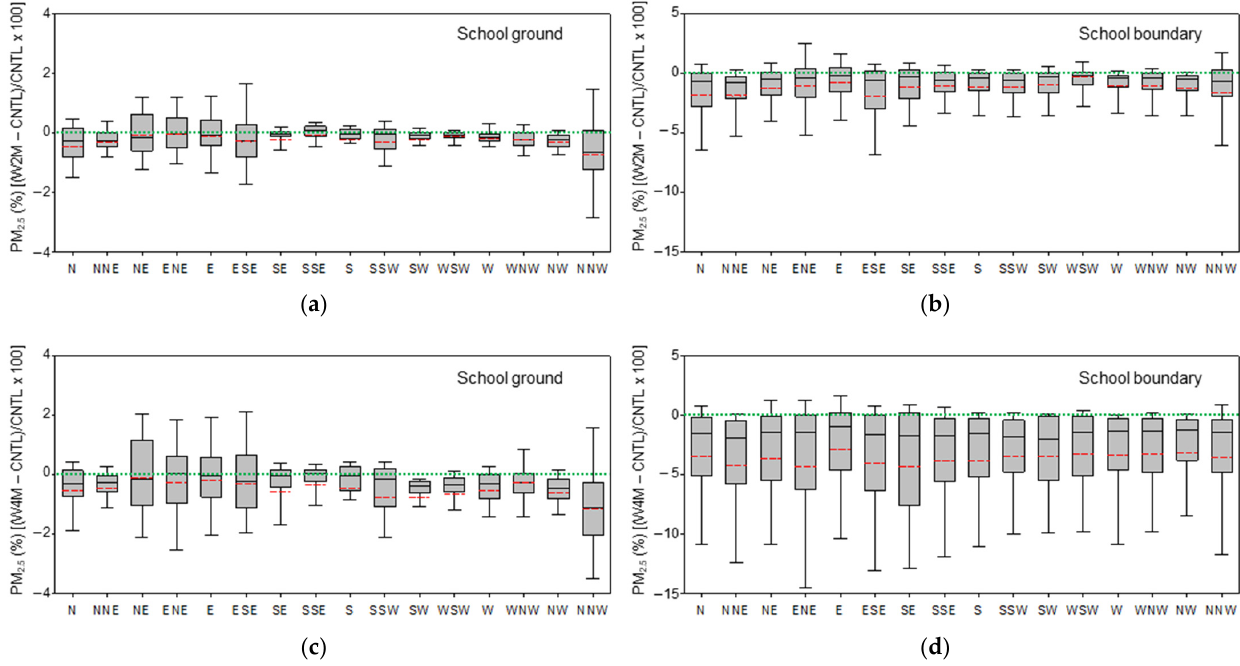
Figure 5. Box plots for the percentage changes of the PM 2.5 concentration (z = 1–11 m heights above the ground) for the W2M ( a , c ) and W4M ( b , d ) compared to the CNTL case in the school ground (left panels) and school boundary (right panels). The bars above and below the boxes indicate the upper and lower extremes, respectively. The upper, middle, and lower segments of the boxes indicate the upper quartiles, medians, and lower quartiles, respectively. The red and green lines indicate the mean value and the zero line, respectively.